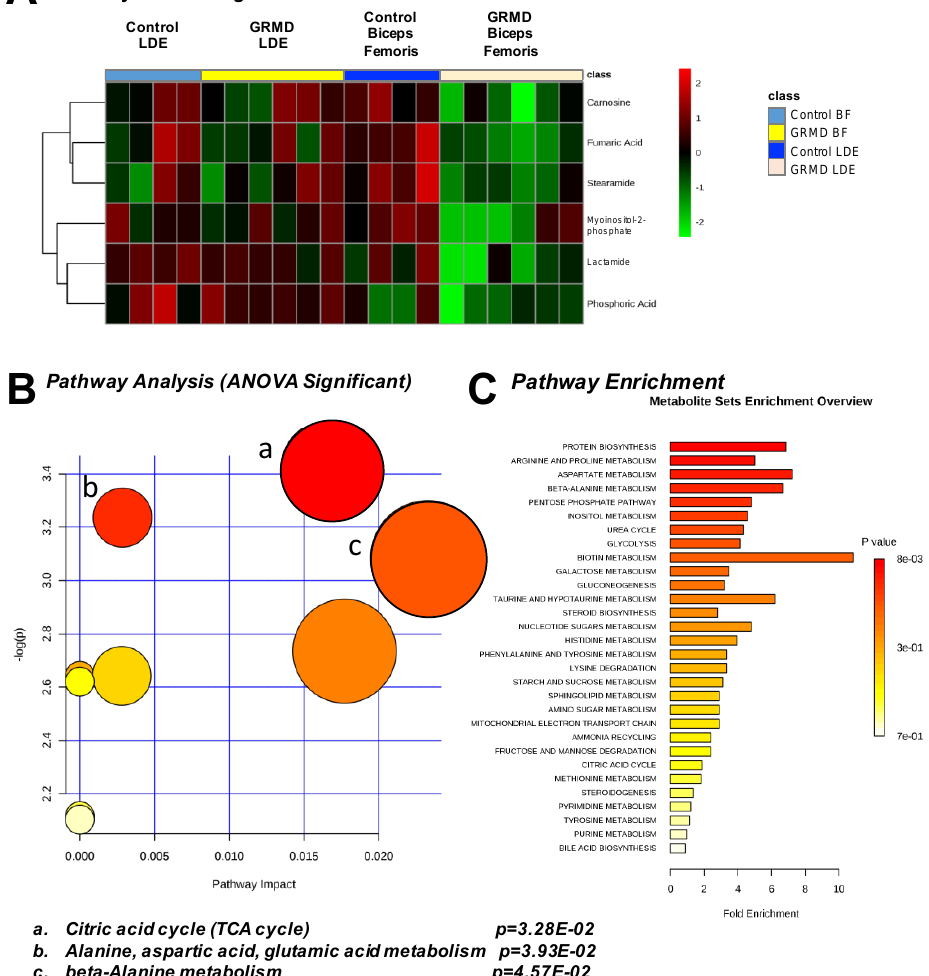
Figure 4. One-Way ANOVA analysis of GRMD long digital extensor (LDE) and biceps femoris (BF). ( A ) Heatmap of ANOVA significant metabolites from control and GRMD LDE and BF; ( B ) Pathway analysis of ANOVA significant metabolites; ( C ) Pathway analysis of ANOVA significant metabolites. Analysis by Metaboanalyst analysis of GRMD (N = 6) vs. control (N = 4) long digital extensor metabolites.